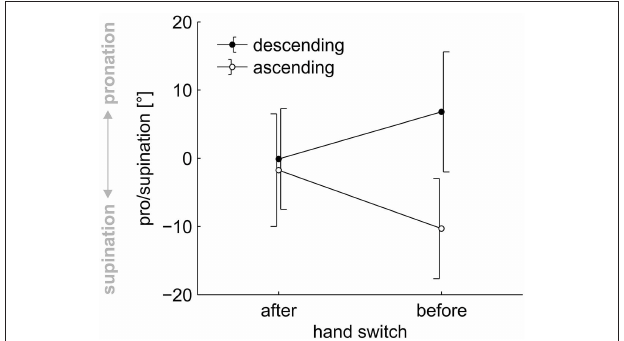
FIGURE 3 | Pro/supination angle for the ascending and descending sequences of trials at drawer #4, before and after a hand switch. Each data point represents the average across the factors “hand”, “repetition”, and “participant”. Error bars indicate 95 % confidence